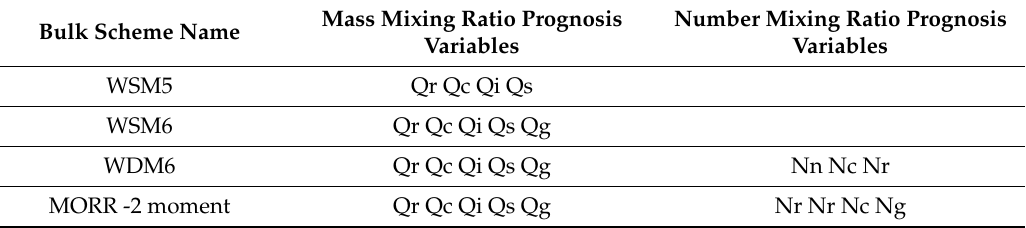
Table 1. Mass mixing ratio and number concentration of variables used in the